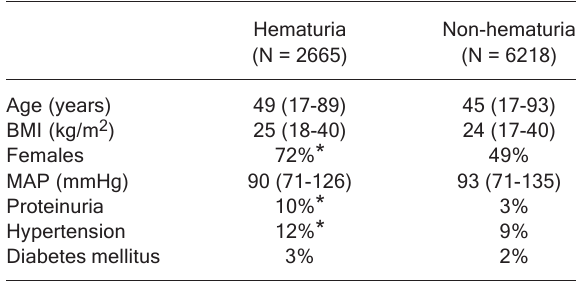
Table 2. Clinical characteristics and dipstick abnormalities in